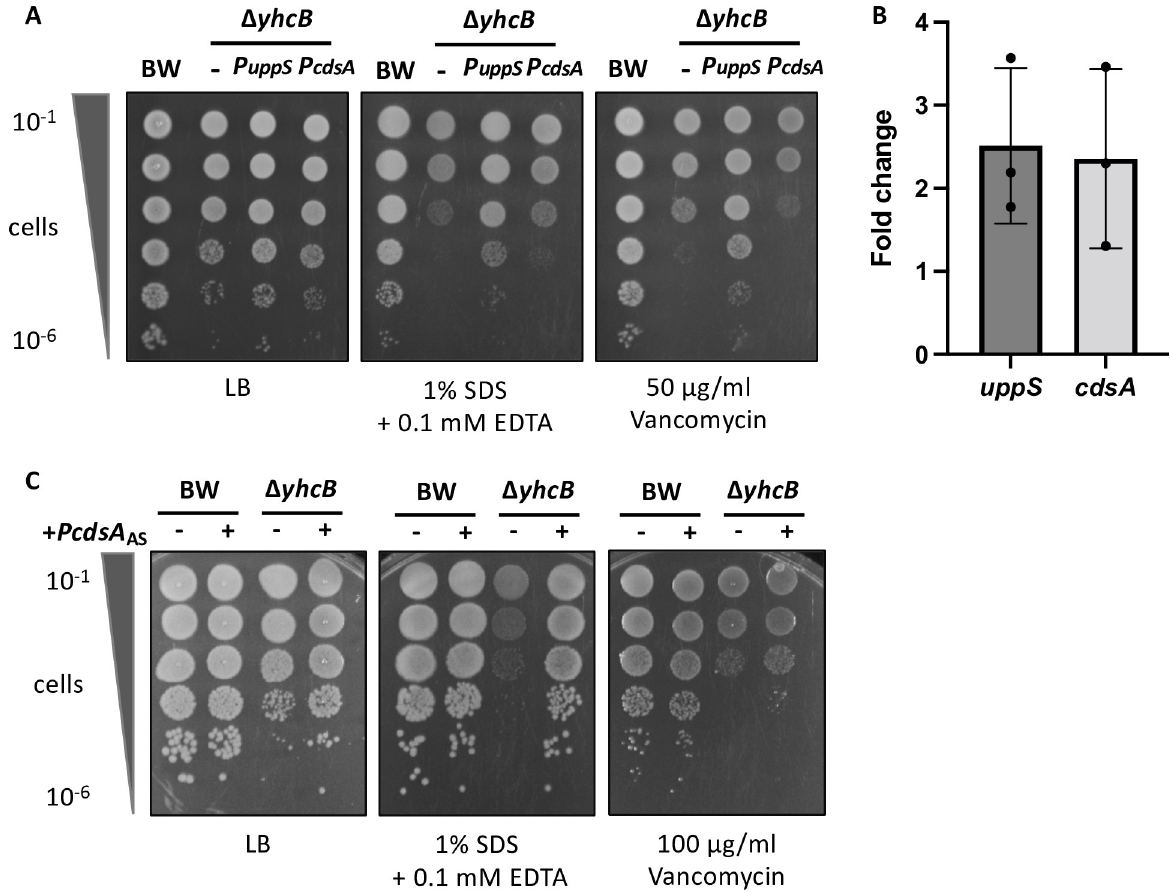
Fig 10. Expression of the uppS-cdsA operon. (A) Cultures of BW25113; Δ yhcB; Δ yhcB/PuppS and Δ yhcB/PcdsA strains grown in LB, normalised to an OD 600 of 1.00 and 10-fold serially diluted before inoculating LB agar plates supplemented with vancomycin or SDS and EDTA. (B) RT-PCR data presented as the relative fold change in abundance of uppS and cdsA transcripts in a yhcB mutant compared to the BW25113 control. Data are normalised to gyrA prior to comparative analyses. Data were collected for three biological replicates. The experiment was repeated twice, a representative plot is shown. (C) Cultures of BW25113; BW25113/ PcdsA AS ; Δ yhcB and Δ yhcB/PcdsA AS strains grown in LB for 5 h, normalised to an OD 600 of 0.05 and 10-fold serially diluted before inoculating LB agar plates supplemented with vancomycin or SDS and EDTA. The PcdsA AS construct contains the antisense nucleotide sequence of cdsA . Expression was not induced, leaky expression was sufficient for complementation